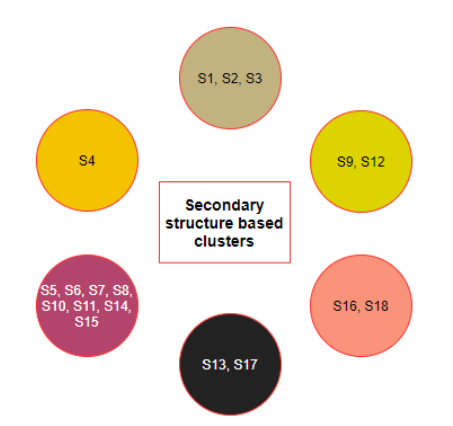
Figure 5. Clusters of species based on the secondary structures of the D1, D2, and D3